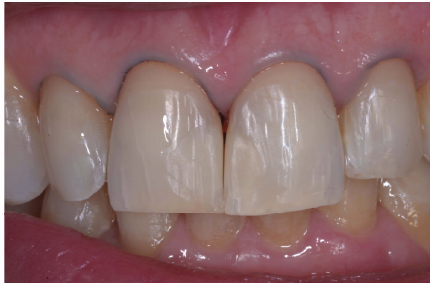
Figure 8: Ultrapak retraction cord in situ.